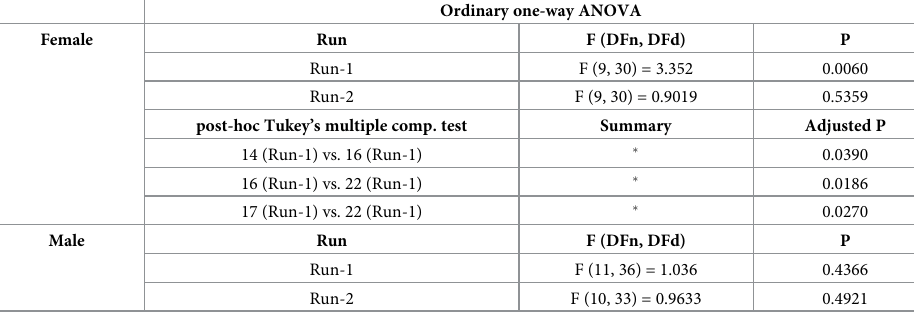
Table 3. Statistical analysis of data shown in Fig 3 for single corner restriction, cohort B.